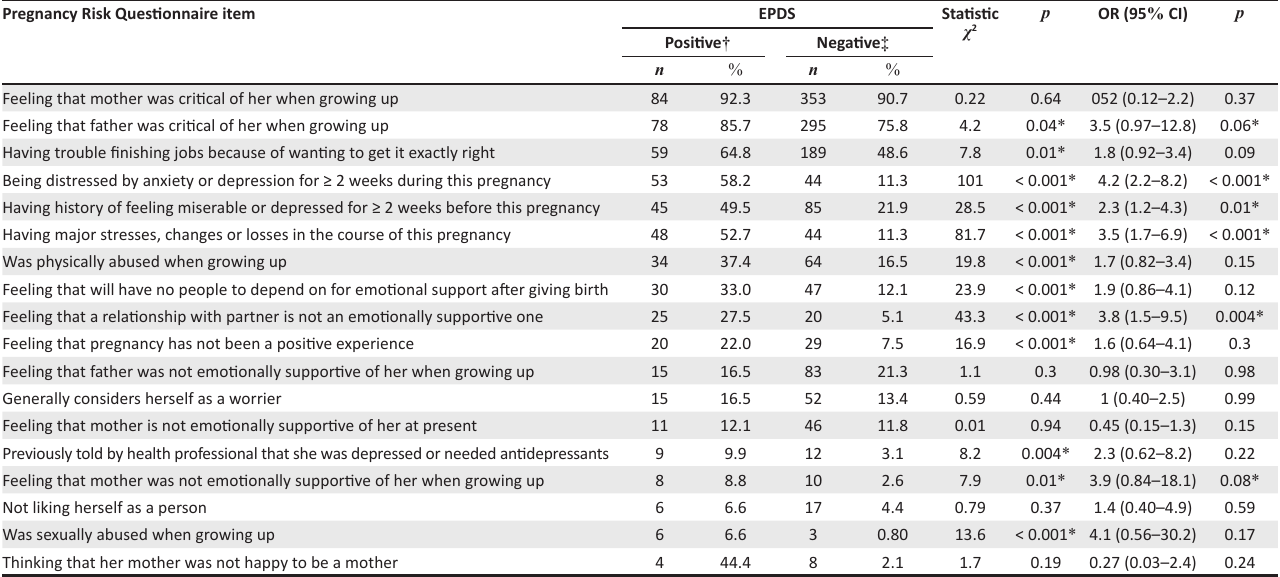
TABLE 2: Psychosocial risk factors associated with antenatal depression. Pregnancy Risk Questionnaire